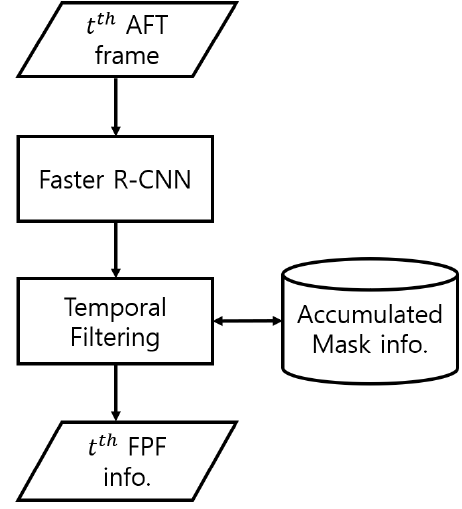
Figure 7. A flow diagram of the proposed